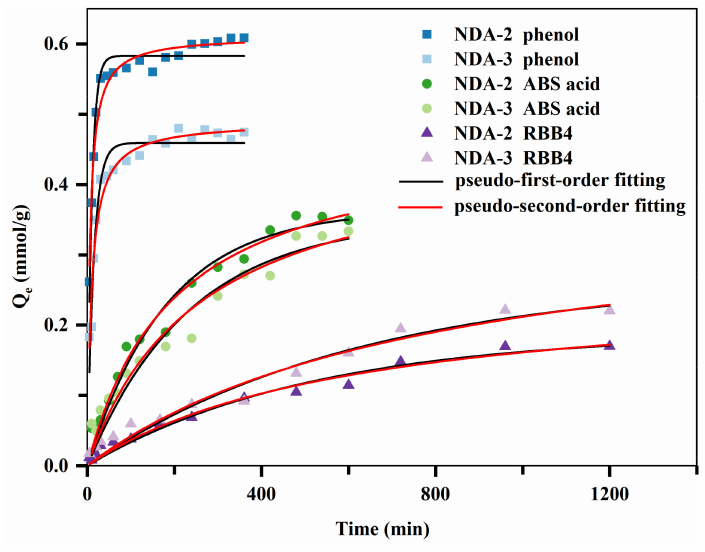
Figure 5. Adsorption kinetic curves of the three adsorbates. Table 3. The corresponding parameters of the adsorption kinetic